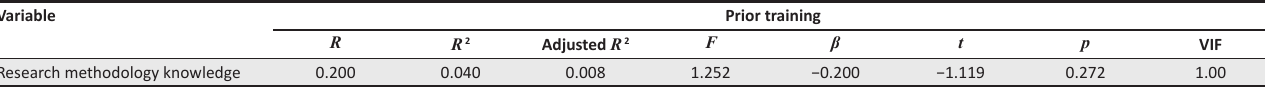
TABLE 7: Multiple regression analysis results with research methodology knowledge after the training intervention as dependent variable and prior training as independent variable.